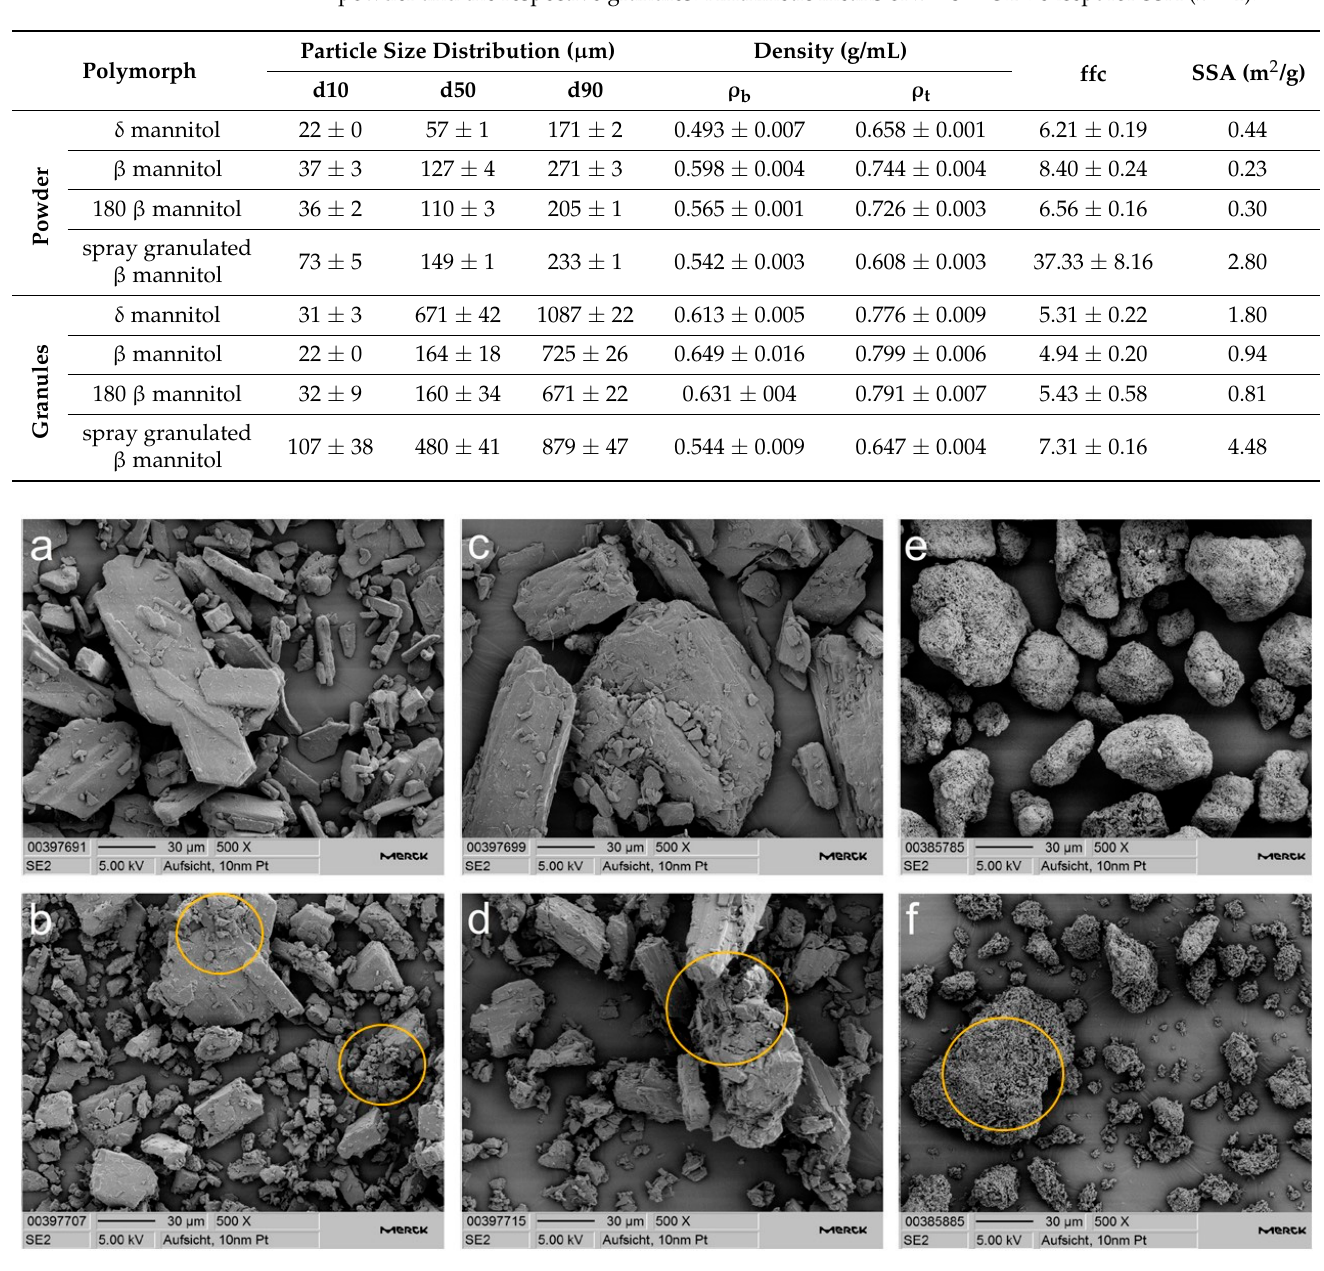
Table 1. Particle size distribution, bulk and tapped density, flowability as ffc value and specific